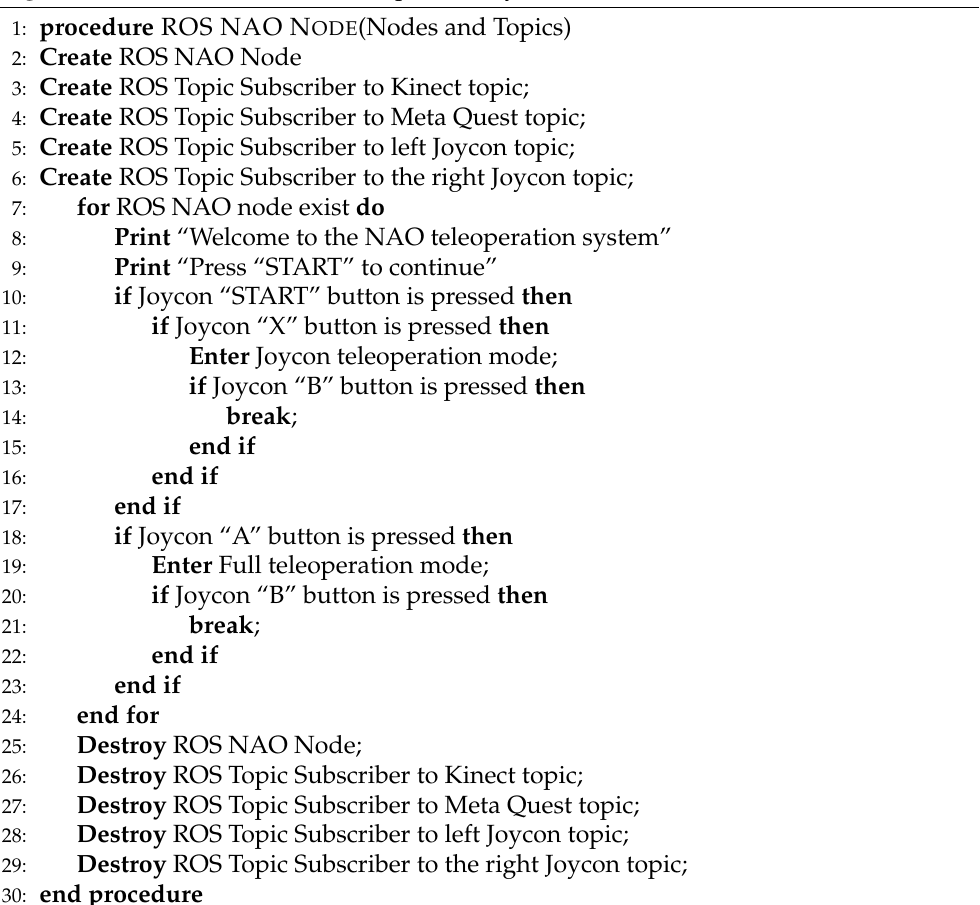
Algorithm 1 Main menu of the teleoperation